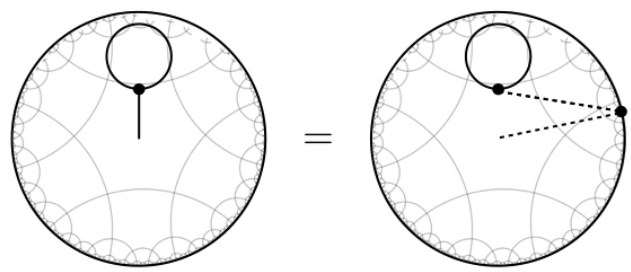
Figure 6. The factorisation (2.96) of the tadpole diagram (2.95) into a tadpole connected to the boundary and a bulk-to-boundary propagator, integrated over their common boundary